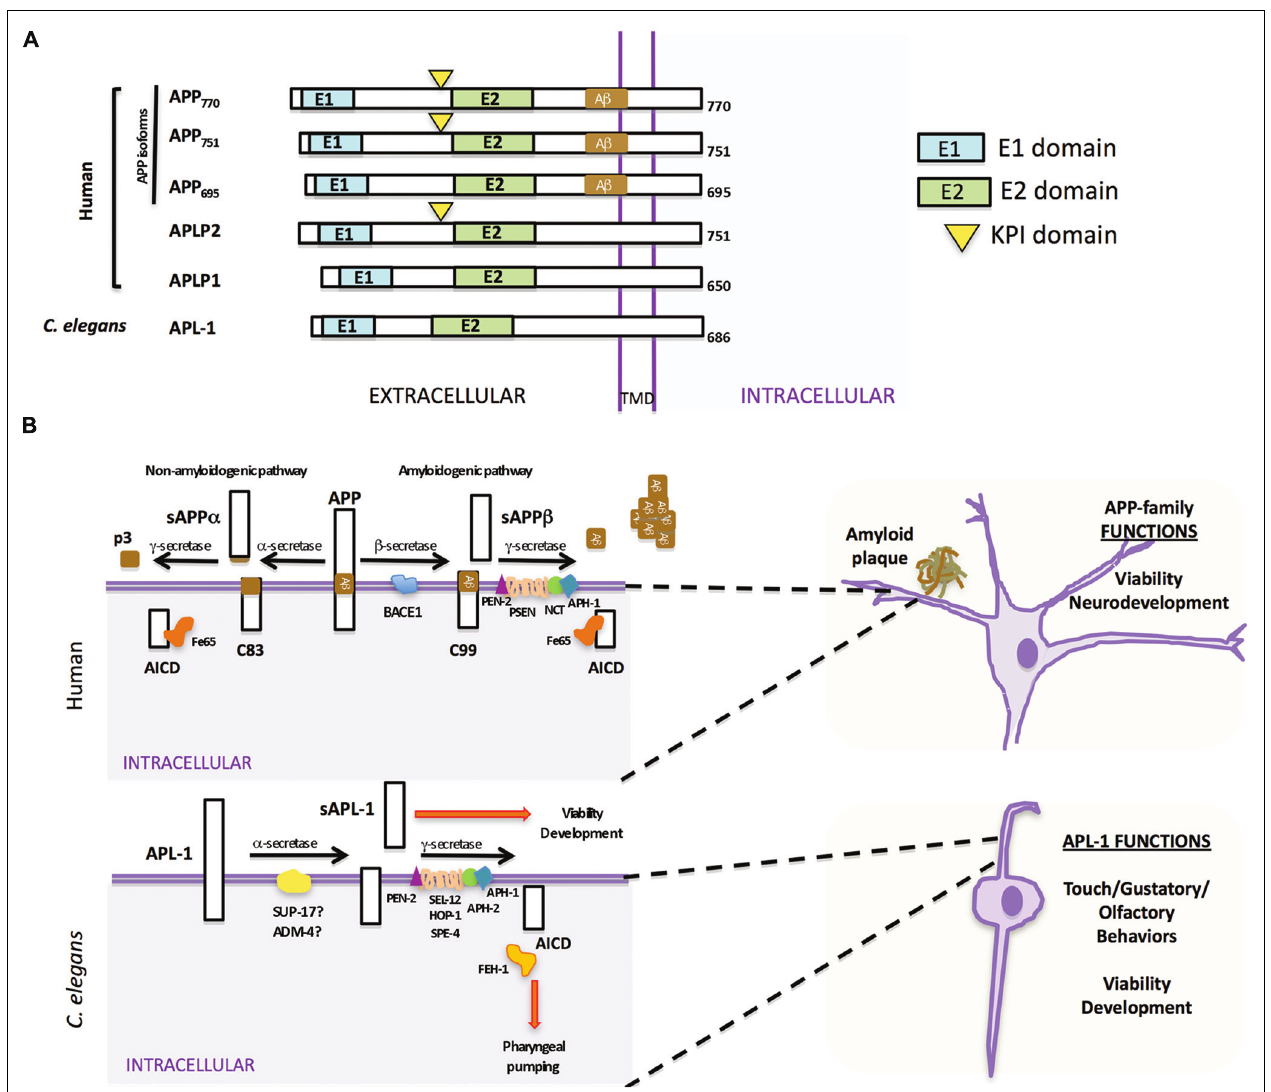
domain (AICD) to the cytosol. In the amyloidogenic pathway, β -secretase first cleaves APP, releasing the sAPP β fragment.The APP-CTF β (C99) fragment is subsequently cleaved by the γ -secretase complex, liberating the AICD to the cytosol and A β to the lumen. A β will aggregate to form amyloid plaques. Bottom . In C. elegans , APL-1 is first cleaved by the α -secretase homologs SUP-17/ADM-4, liberating the extracellular sAPL-1 that is known to regulate worm viability and development.The γ -secretase complex will then cleave the remaining APL-1-CTF to release AICD into the cytosol. General functions of the APP family and APL-1 are